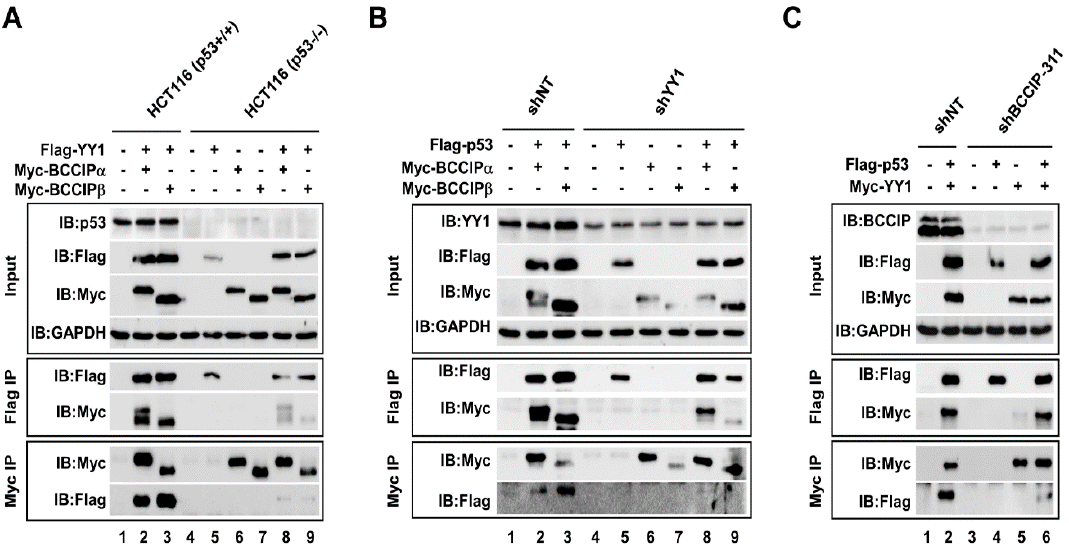
Figure 3. Cross-interaction between BCCIP, YY1, and p53 was verified in HCT116 (p53+/+) cells. ( A ) Interaction between BCCIP and YY1. In vitro co-transfection/coimmunoprecipitation (CoIP) experiments with anti-Flag M2 and anti-c-Myc affinity agarose were carried out in HCT116 (p53+/+) and HCT116 (p53 − / − ) whole-cell lysates. Bound proteins were visualized by western blot. ( B ) Interaction between p53 and BCCIP in shNT- and shYY1-treated HCT116 cells. CoIP experiments with anti-Flag M2 and anti-Myc antibodies were performed in HCT116 cells, and bound proteins were detected by western blot. ( C ) Interaction between p53 and YY1 in shNT- and shBCCIP-treated HCT116 cells. CoIP experiments with anti-Flag M2 and anti-Myc antibodies were done as designed. 2.3. BCCIP and YY1 Coordinate the p53 Responsive Element (RE) Mediated Luciferase Activity in HCT116